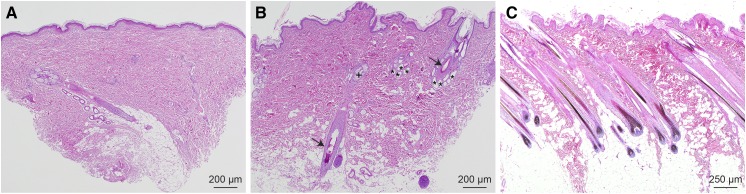
Histopathology of a dog with ectodermal dysplasia. (A) Image taken from an alopecic area. Only one simple hair follicle with its associated sebaceous and sweat glands is present within the entire dermis. Stained with hematoxylin & eosin. (B) Image taken from a hypotrichotic area. Hair follicles are distributed regularly within the dermis. These are also simple follicles, and, only rarely, two follicles are neighboring each other. Stained with hematoxylin & eosin. (C) Skin biopsy of a normal dog. The hair follicles are grouped together forming compounds composed of several hair follicles, sweat glands, and sebaceous glands. Stained with hematoxylin & eosin. The arrows in (B) depict hair follicles, the stars indicate sweat glands, and the plus sign indicates sebaceous glands.